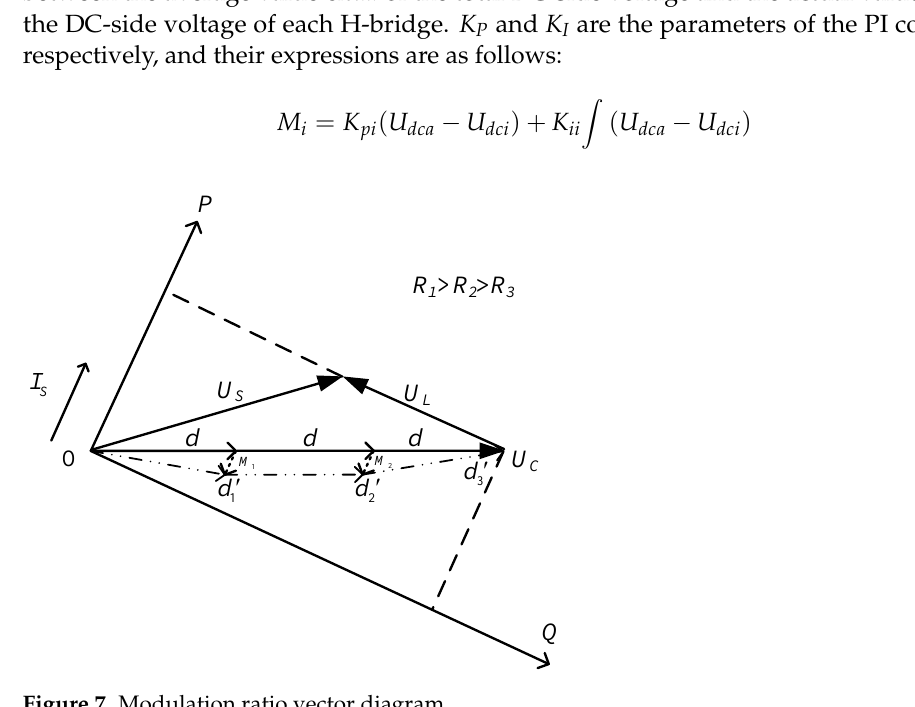
Figure 7. Modulation ratio vector diagram.